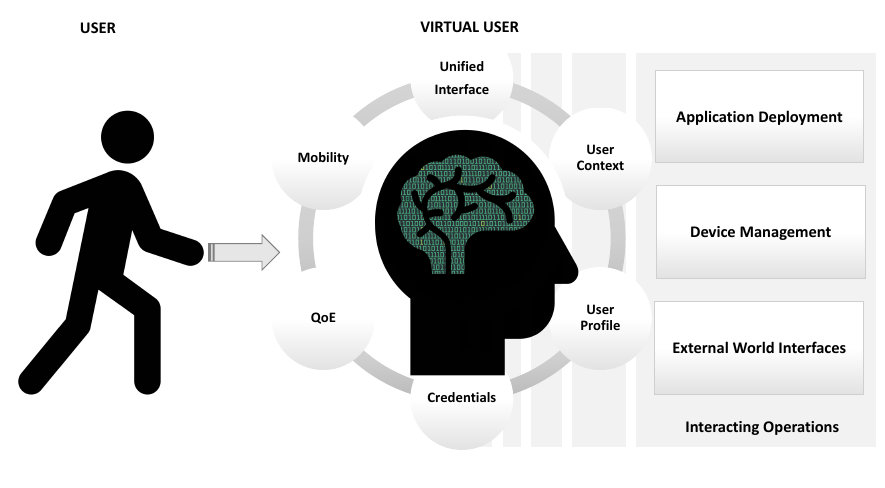
Figure 1. The VU scenario.